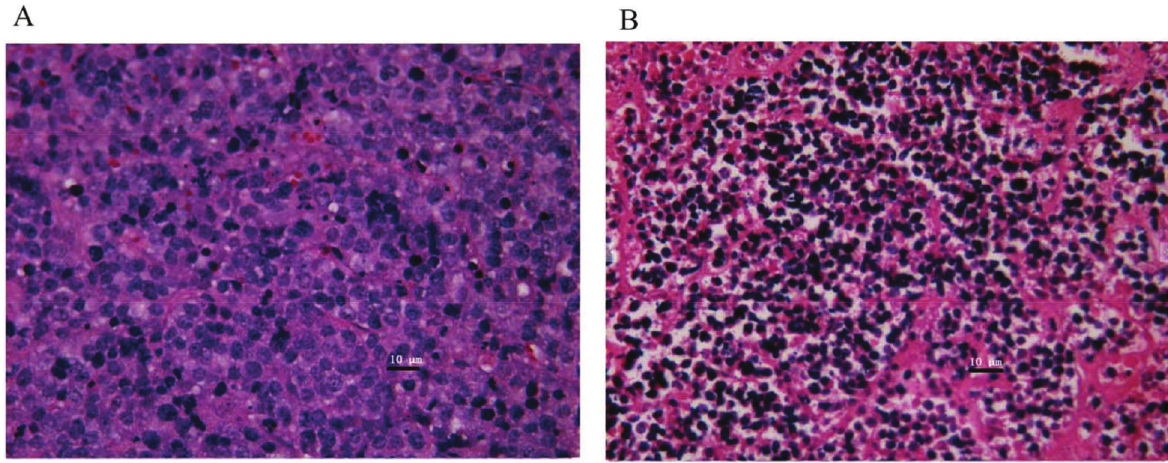
Figure 3. Histology of liver metastasis from one P2 patient-derived tumor xenograft (PDTX) tumor. Microphotographs of H&E staining (magni fi cation (cid:1) 40) in 1 animal revealed that metastatic lesions in the liver ( A ) and its PDTX P2 tumor ( B ) had the same cell morphology. Both are small cell